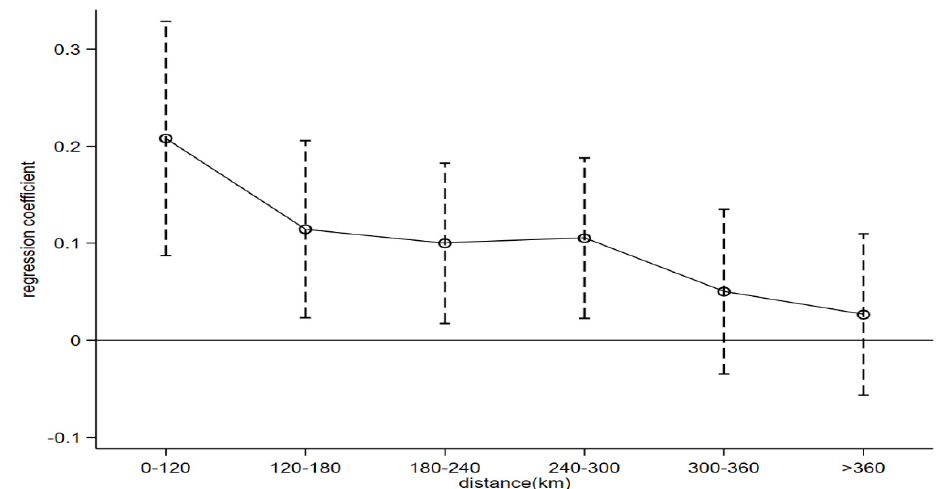
Figure 6. The basic effect of pilot policies in terms of spatial